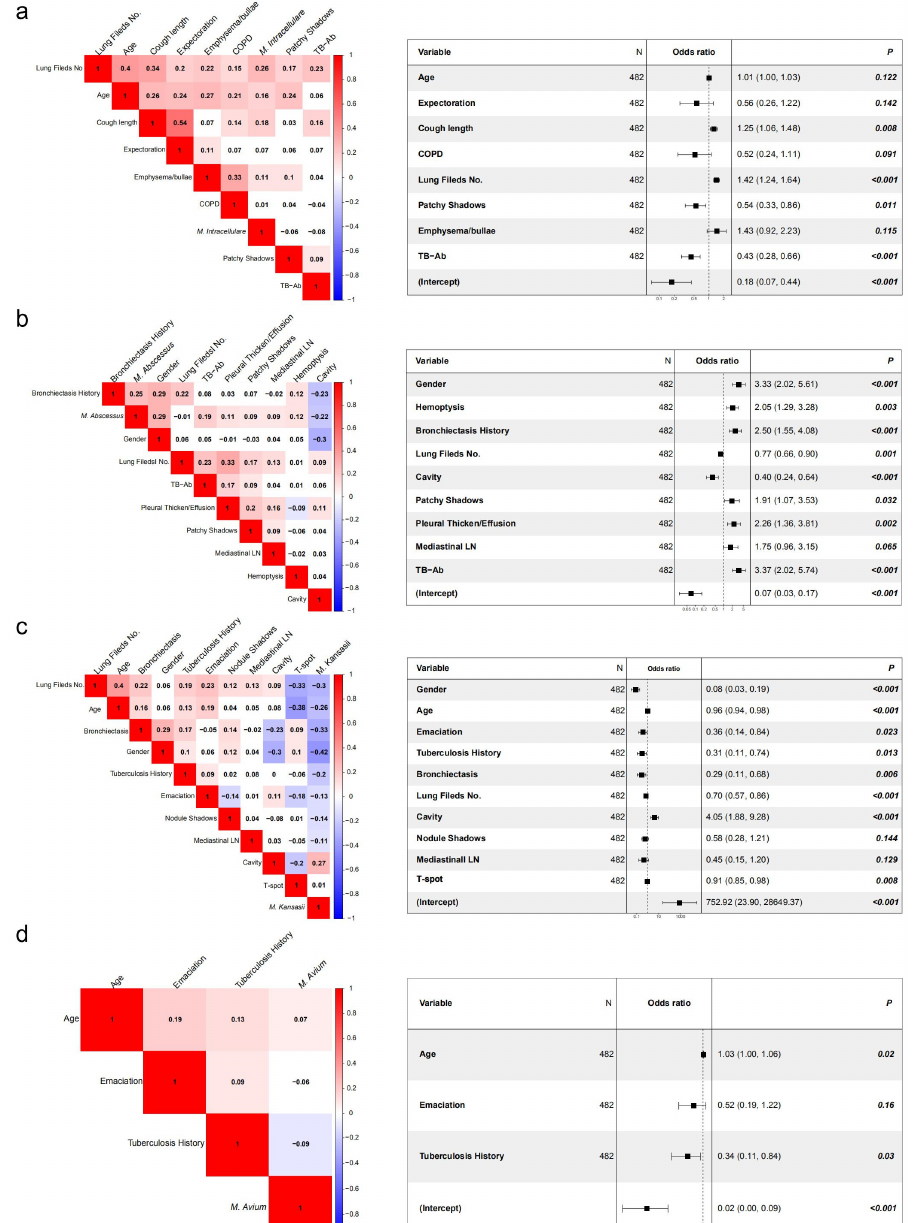
Figure 4. ( a ) The results of correlation analysis in the M. intracellulare group: the M . intracellulare pulmonary disease was positively correlated with the duration of cough and the number of involved lung fields on imaging, and negatively correlated with positive blood tuberculosis antibody and patchy shadow on imaging (all p < 0.05). ( b ) The results of correlation analysis in the M . abscessus group: M . abscessus pulmonary disease was positively correlated with female sex, hemoptysis, previous history of bronchiectasis, positive blood tuberculosis antibody, patchy shadow on imaging, and pleural thickening or pleural effusion, and negatively correlated with cavity on imaging and the number of involved lung fields (all p < 0.05). ( c ) The results of correlation analysis in the M . kansasii group: M . kansasii pulmonary disease was positively correlated with positive T-Spot and cavity on imaging, and negatively correlated with female, age, emaciation, previous history of pulmonary tuberculosis, bronchiectasis, and the number of involved lung fields on imaging (all p < 0.05). ( d ) The results of correlation analysis in the M . avium group: M . avium pulmonary disease was positively correlated with age and negatively correlated with the previous history of pulmonary tuberculosis (all p < 0.05).